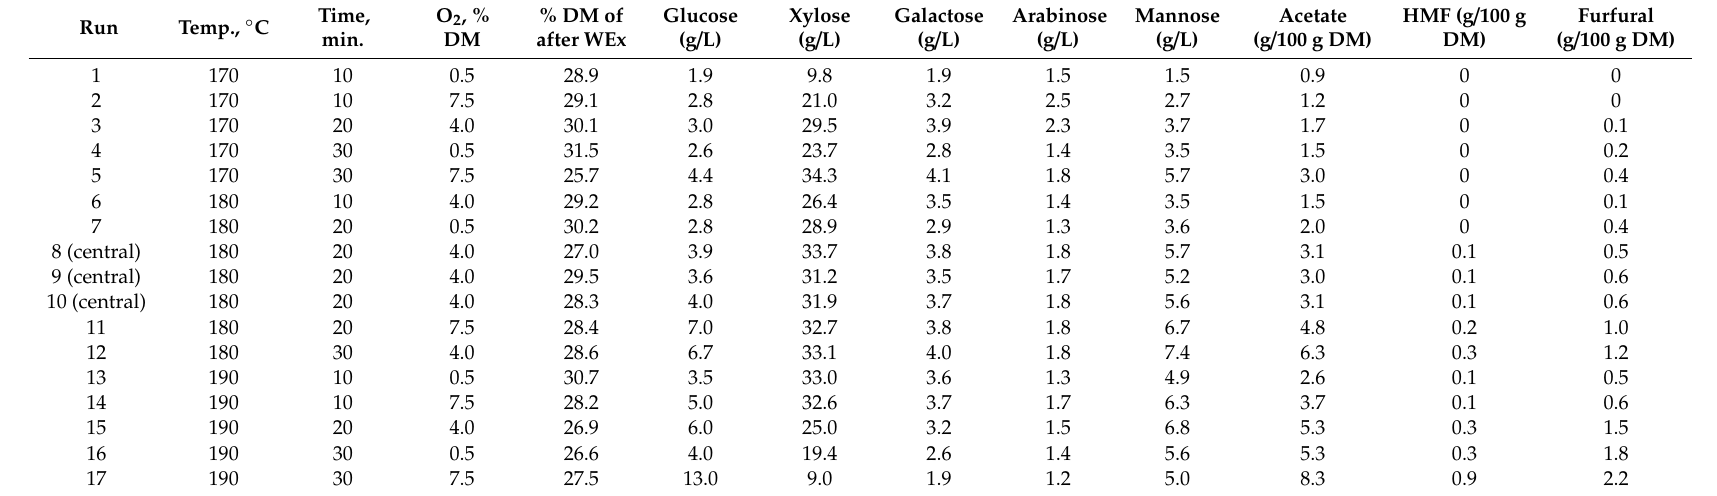
Table 2. Conditions used for wet explosion (WEx) pretreatment at 30% initial dry matter. Soluble sugars and degradation products were measured in the liquid phase after dilute acid